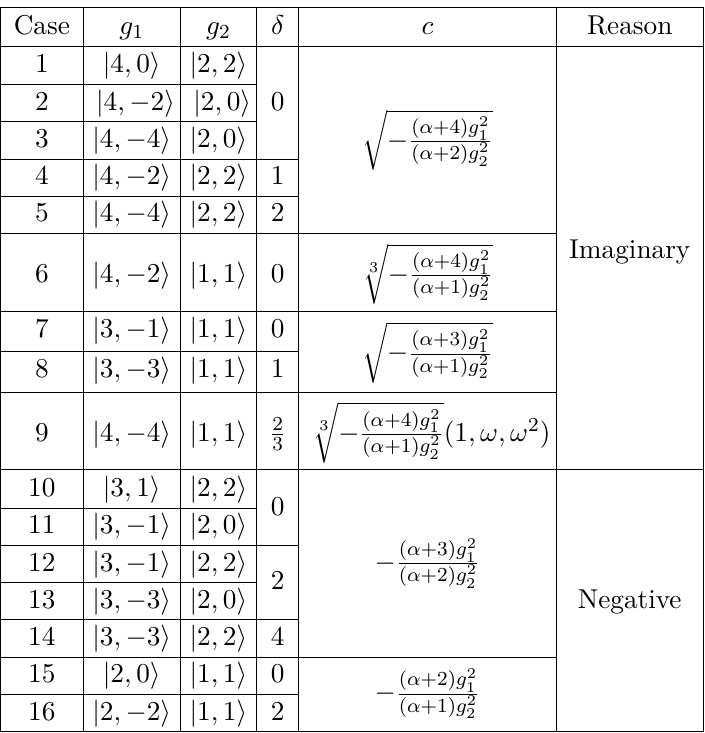
Table 1 . Bad cases with two different d ’s. In the c column we have omitted non-essential normalization factors to display their shared properties. The last column points out the reason that invalidates the solution to c . Case 9 has three solutions to its prefactor c , and they differ from each other by a factor of ω = e 2 π i / 3